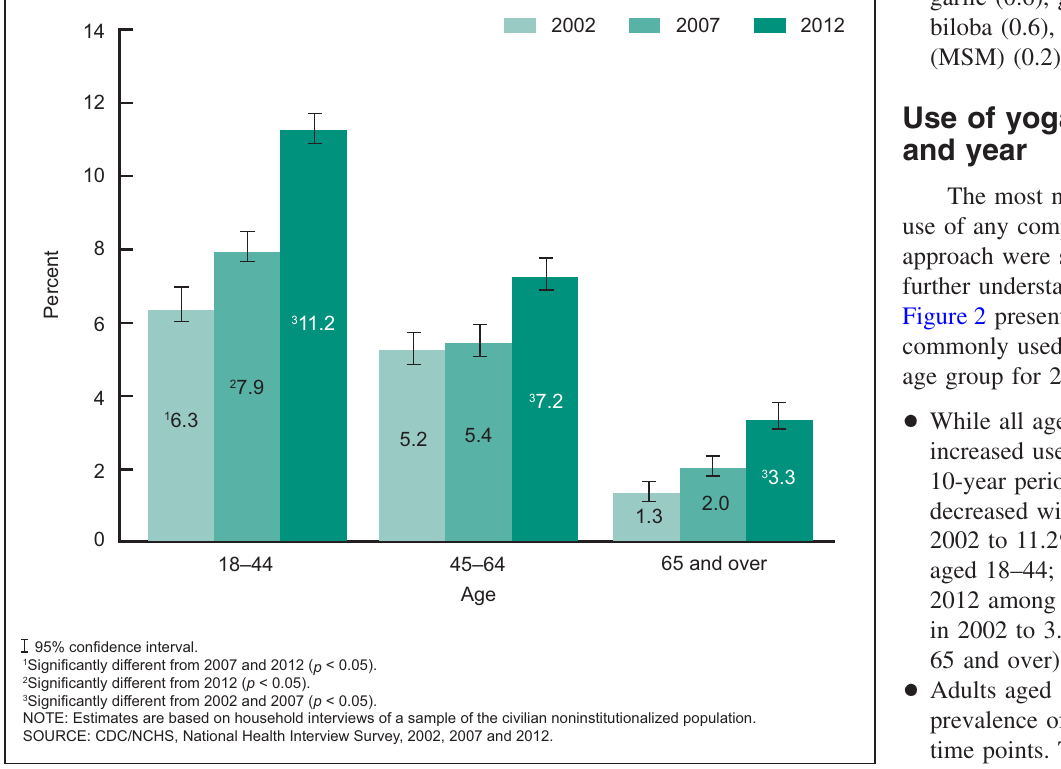
private insurance (34.6% in 2002, 39.0% in 2007, and 38.0% in 2012) and public coverage (25.8% in 2002, 27.0% in 2007, and 24.8% in 2012) as well as the uninsured (28.4% in